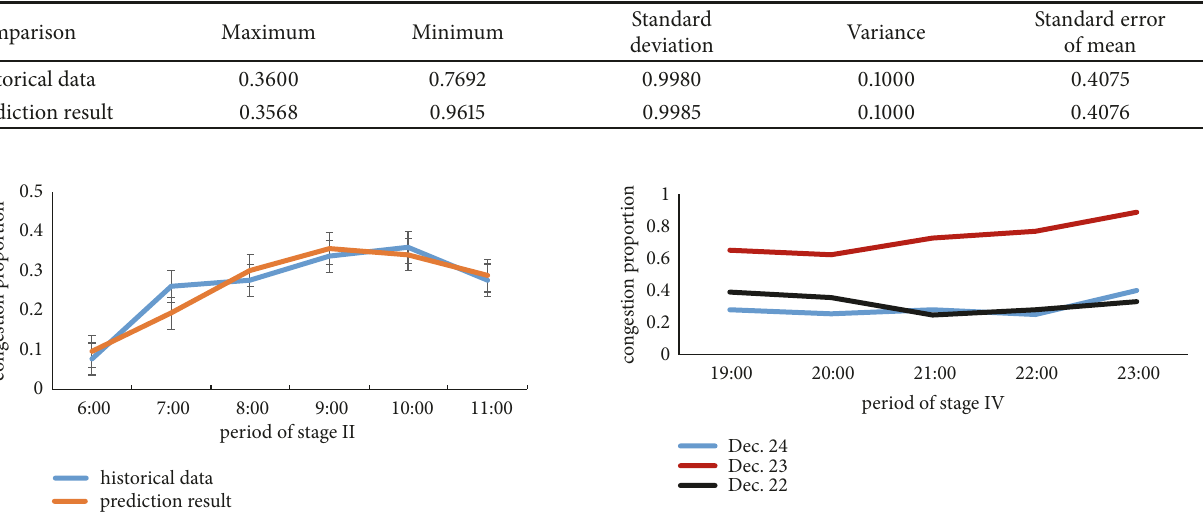
Figure 11: Comparison between the prediction result and historic data for stage II.